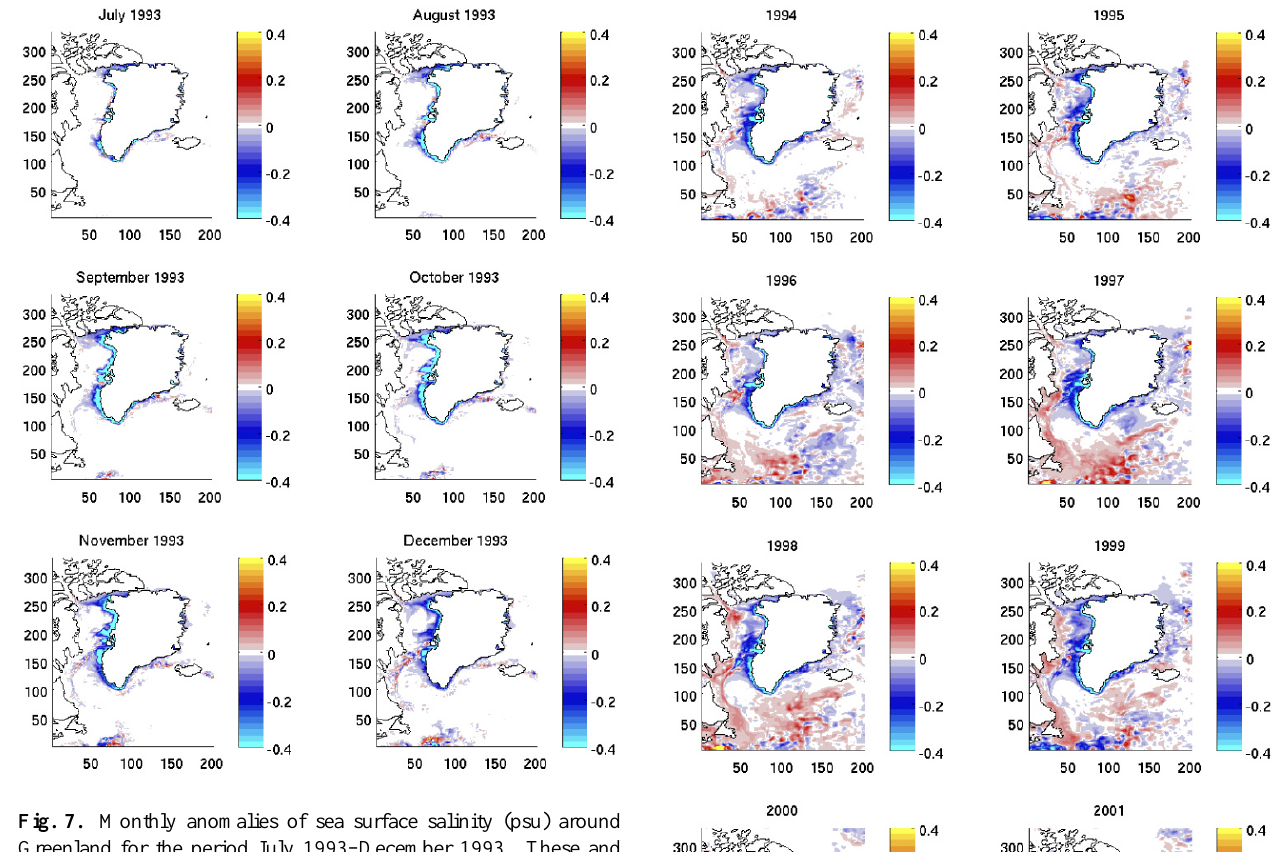
Fig. 7. Monthly anomalies of sea surface salinity (psu) around Greenland for the period July 1993–December 1993. These and subsequent anomalies are obtained as “sensitivity minus control” differences.